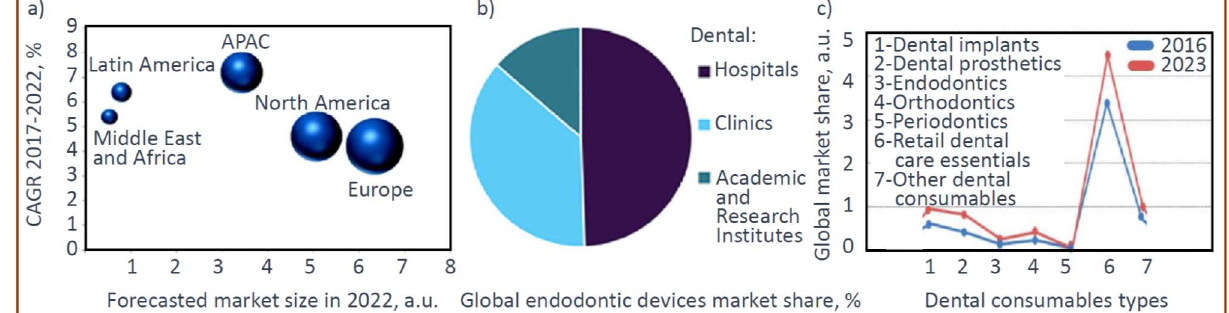
Figure 3. Forecasts for the growth of dental markets: ( a ) matrix of the forecasted size of the endodontics market (the diameter of the marker symbolizes the relative value) depending on the CAGR; ( b ) breakdown of the global endodontics market in 2018 by end-user; ( c ) an increase in the dental consumables market with the participation of endodontics in 2016−2023.